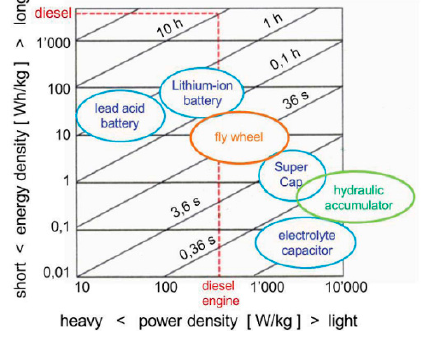
Energies 2020 , 13 , x FOR PEER REVIEW Figure 14. Performance comparisons of various energy storage devices [125]. Figure 14. Performance comparisons of various energy storage devices [125].